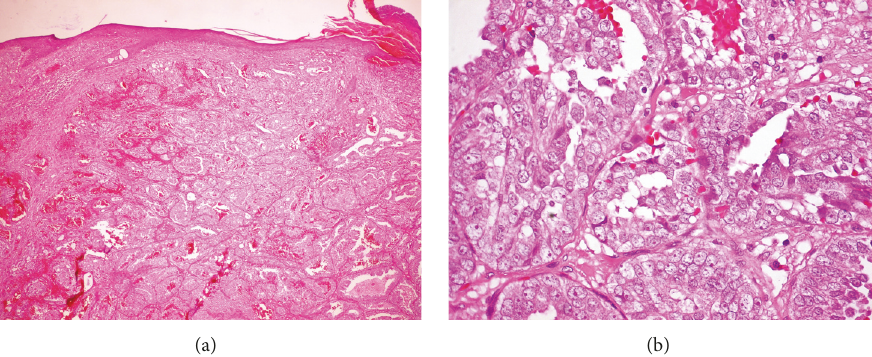
Figure 2: (a) The skin biopsy showed abundant hematic crust and ulcerated areas in the epidermis. Ectatic abundant vessels were observed at the entire thickness of the papillar and reticular dermis. (b) Cells with broad, abundant, clear cytoplasm in ductal arrangement were observed.Thisaspectwassuggestiveofskinmetastasesofglandularneoplasia,includingprostateorthyroid(hematoxylin-eosinstain;original magnifications: 40x (a); 400x (a,